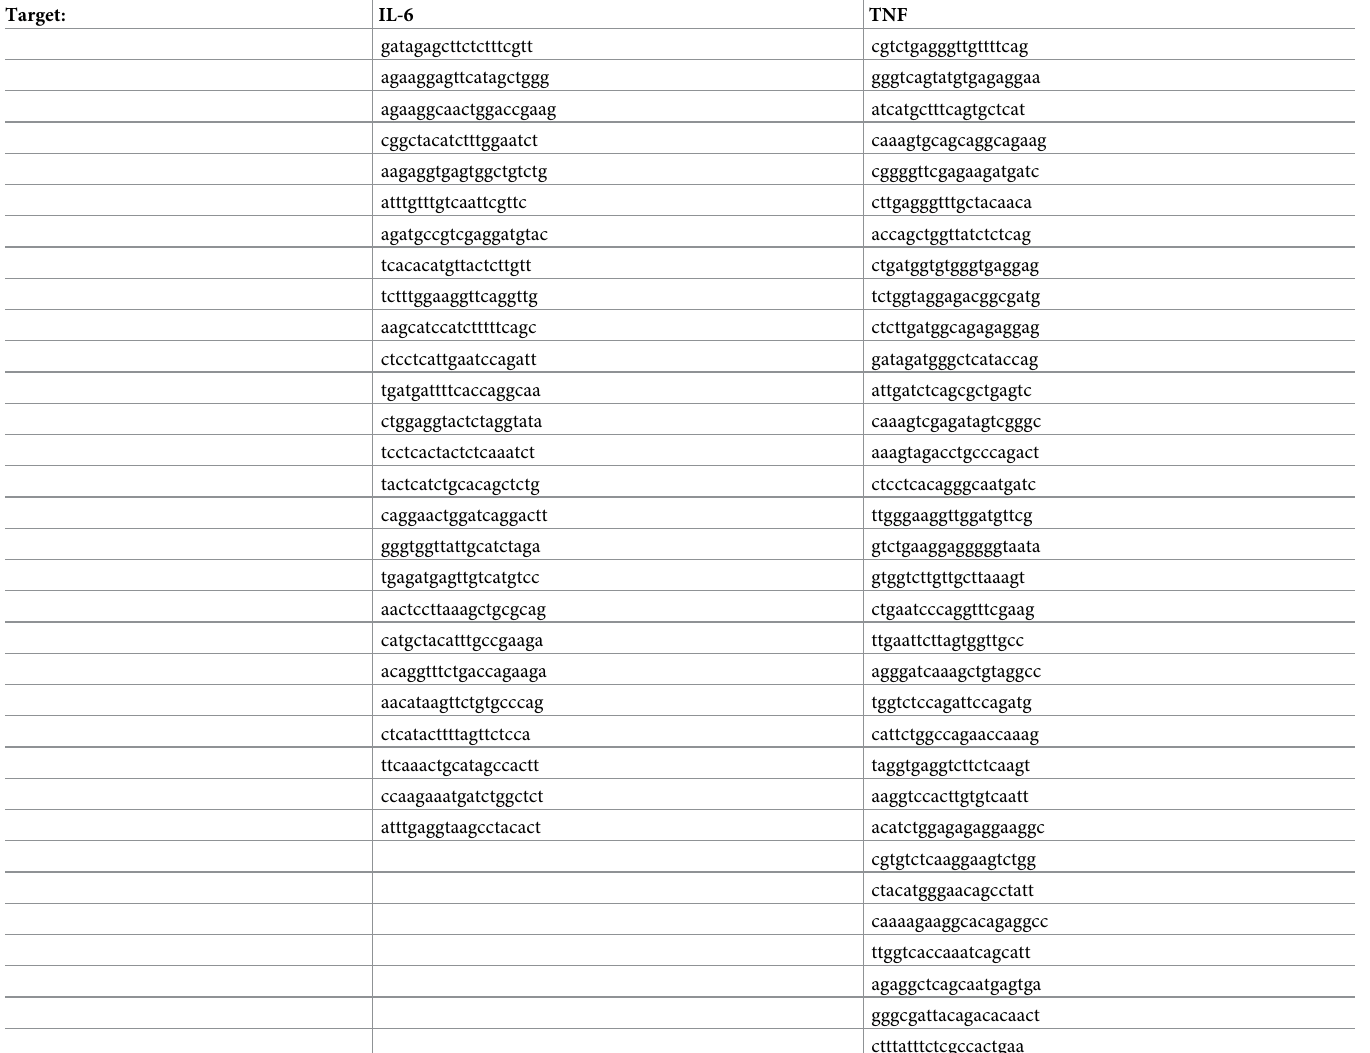
Table 3. Probes for RNA Fluorescent in situ hybridization.